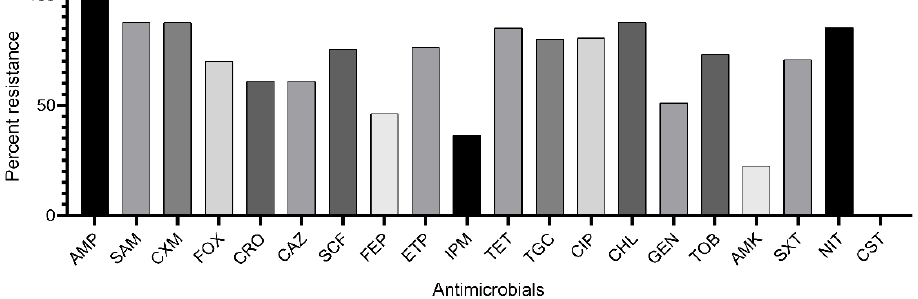
Figure 1. Rate of K. pneumoniae isolates resistant to antimicrobials: AMP, ampicillin; SAM, ampicillin- sulbactam; CXM, cefuroxime; FOX, cefoxitin; CRO, ceftriaxone; CAZ, ceftazidime; SCF, cefoperazone-